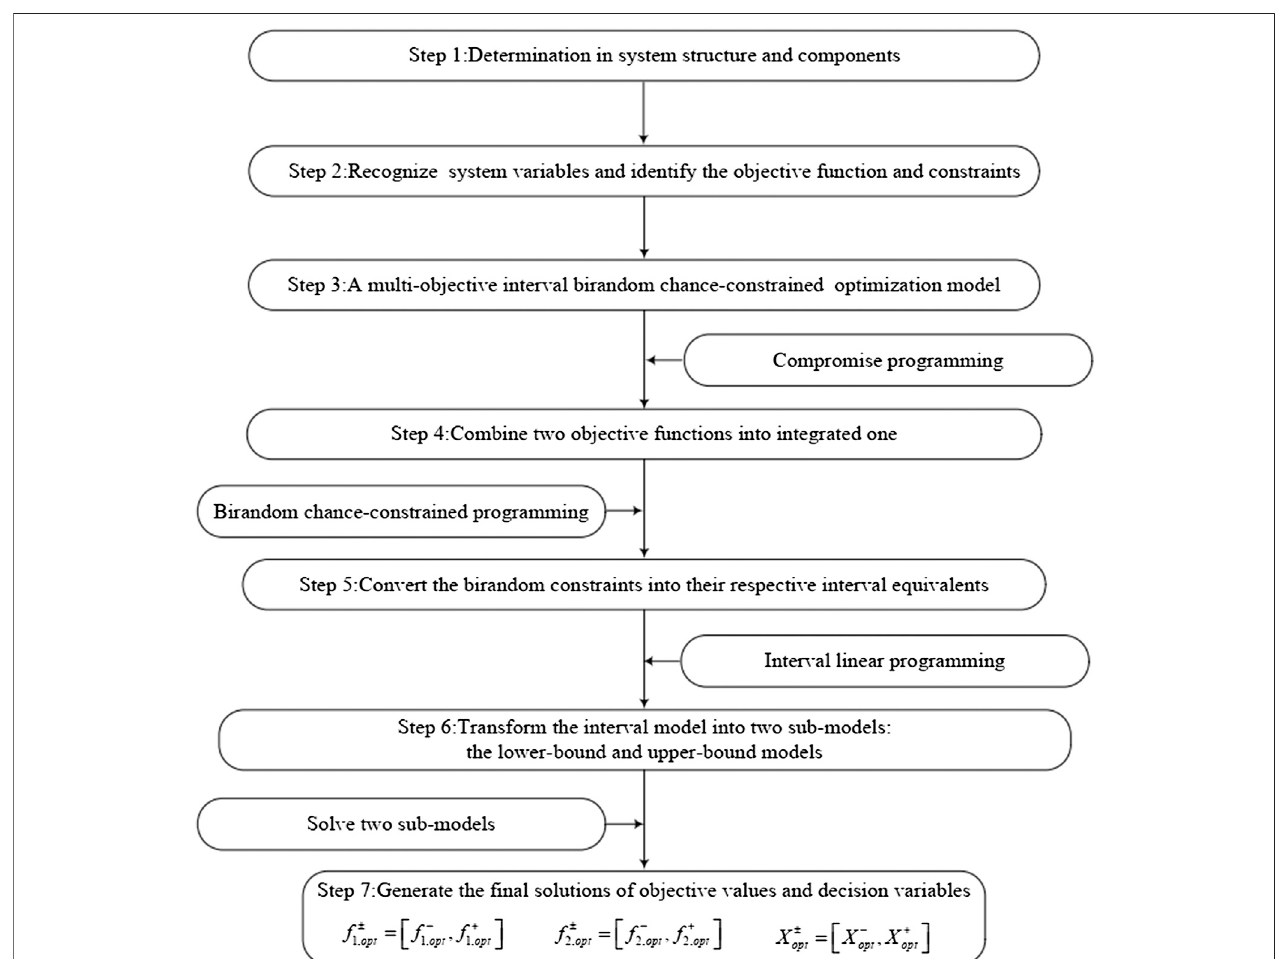
FIGURE 1 | Main procedure of formulating and solving a multi-objective interval birandom chance-constrained programming model.